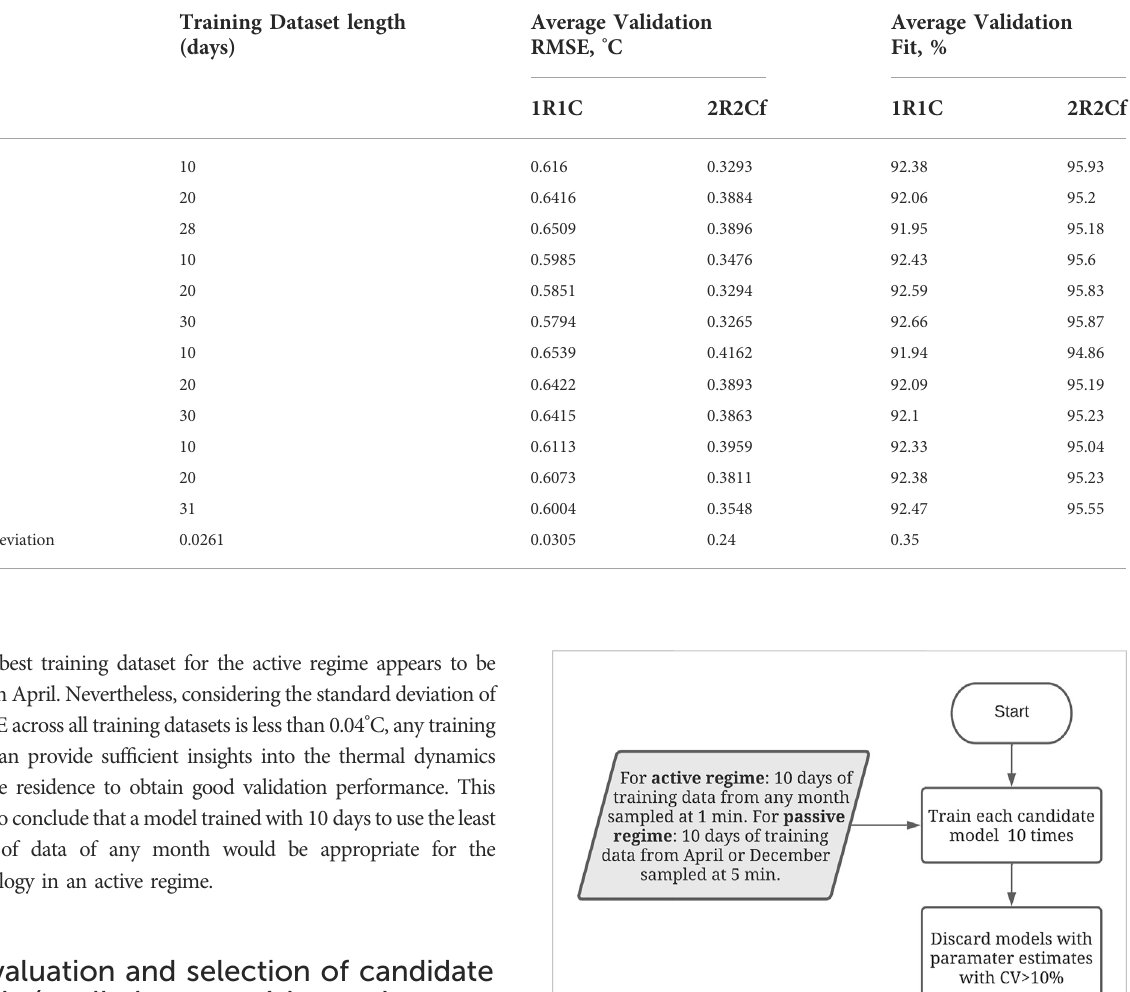
TABLE 4 Validation results for networks in the active regime for Case 1.